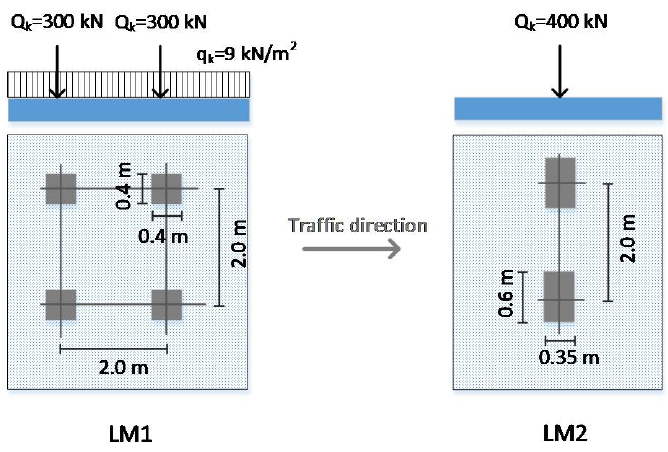
Figure 7. Illustration of load models LM1 and LM2 .